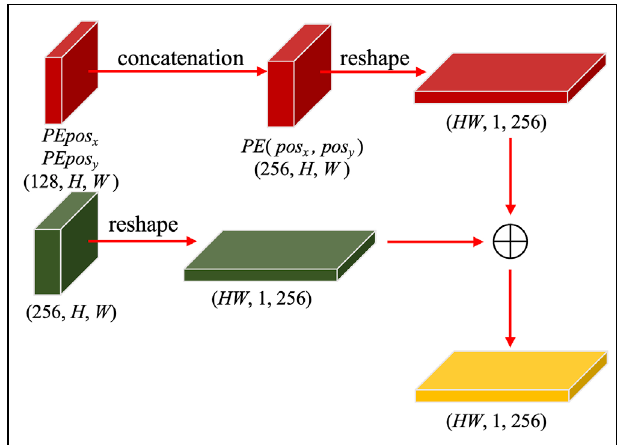
FIGURE 3 | Add positional encoding to the feature